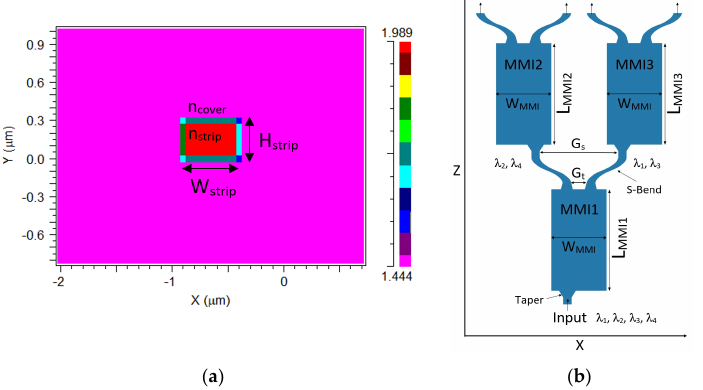
Figure 1. An illustration of the 1 × 4 wavelength demultiplexer: ( a ) in the XY plane alongside the refractive index bar and ( b ) in the XZ plane.